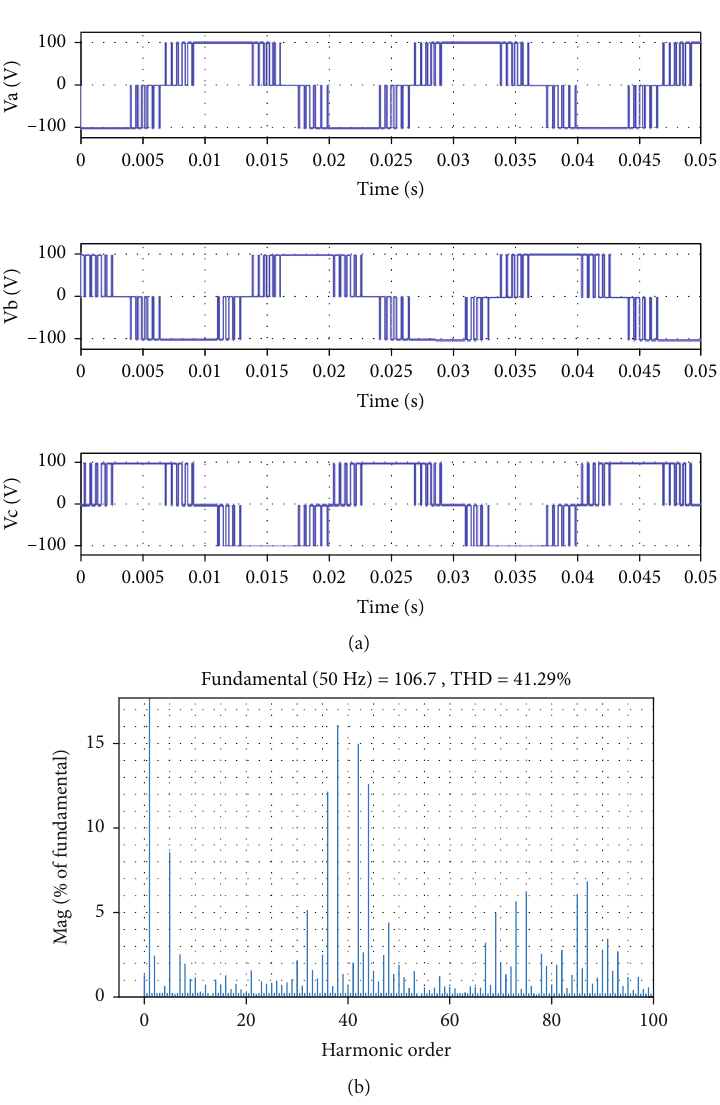
V V a , b , and c ) and spectrum of line